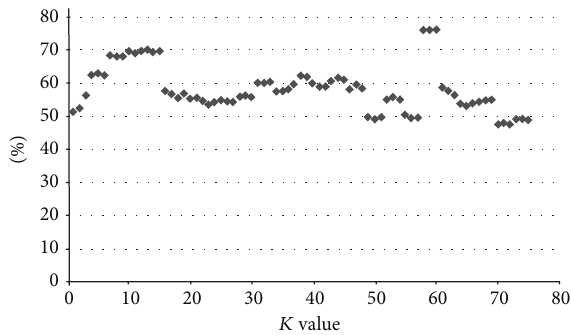
Figure 4: 𝐾 value, freshness quality index of canned salmon.